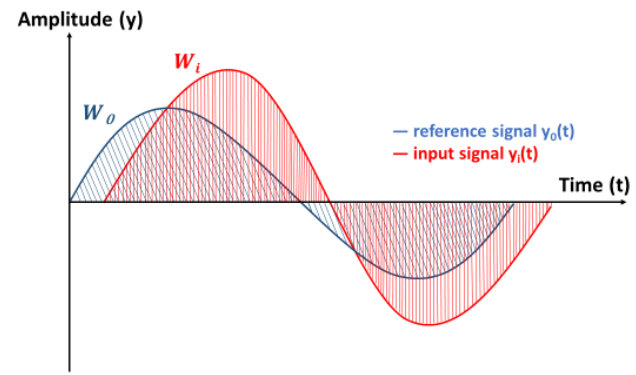
Figure 10. Representation of work deviation, given by the non-intersecting area of signals y 0 (t) and y i (t).